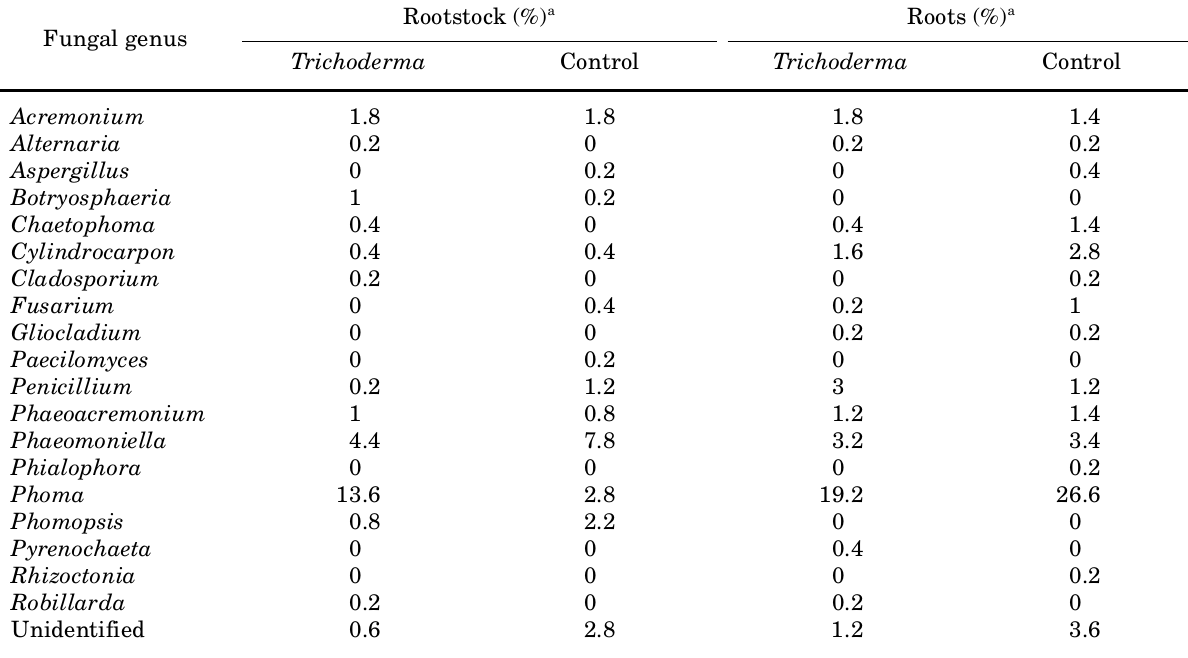
Table 2. Percentage of various fungal genera isolated from rootstocks and roots of Trichoderma treated and stand- ard treated (control) nursery grapevines.